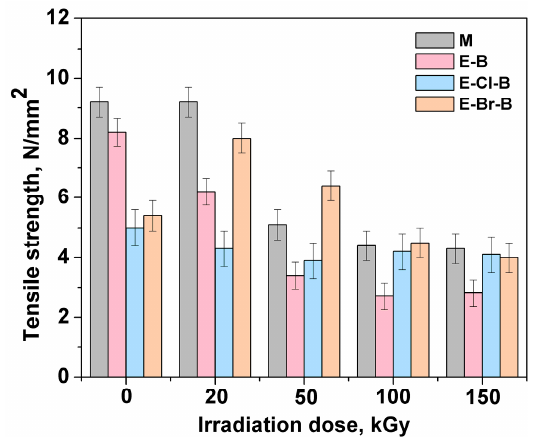
Figure 4. Variation of 300% modulus of EPDM/butyl rubber composites with irradiation dose.